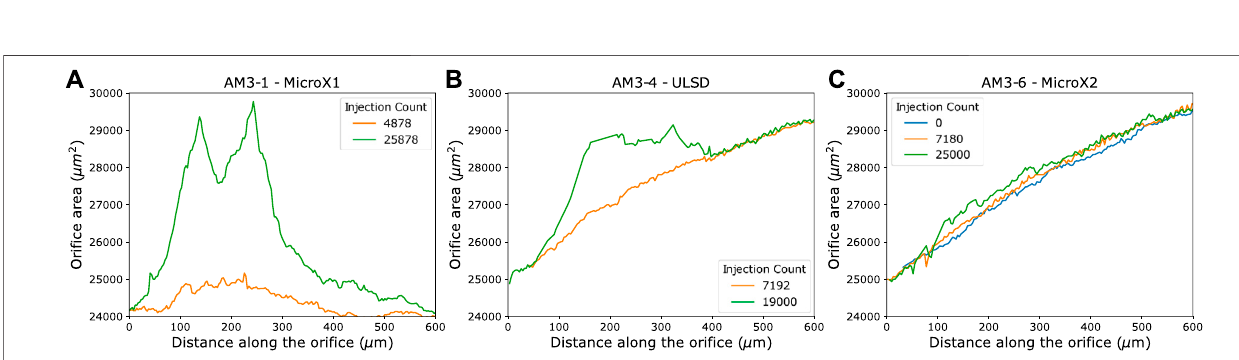
Frontiers in Mechanical Engineering |